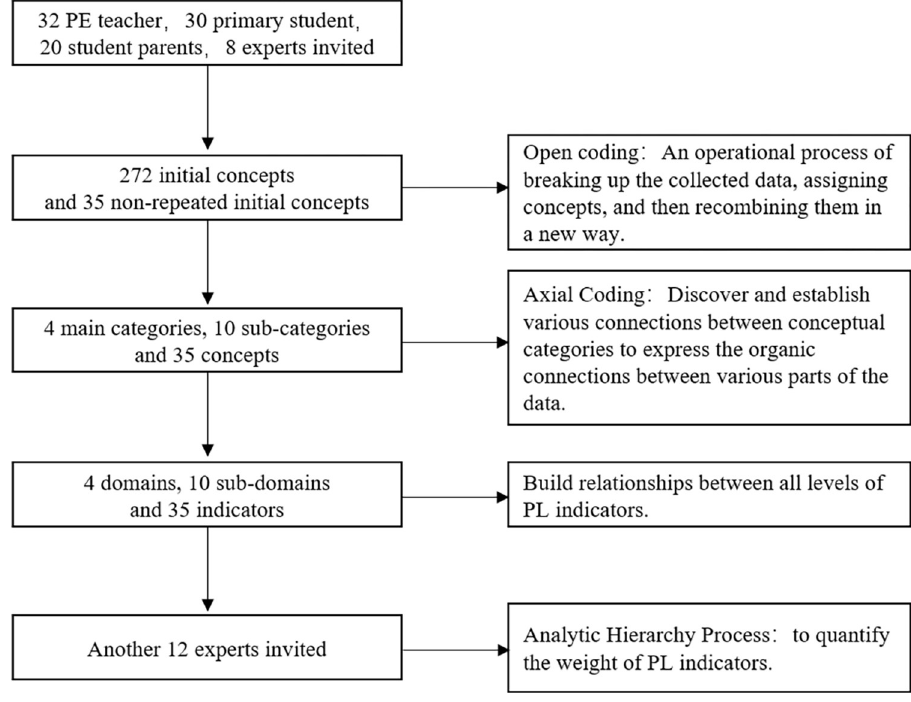
Fig 1. Paradigm of grounded theory